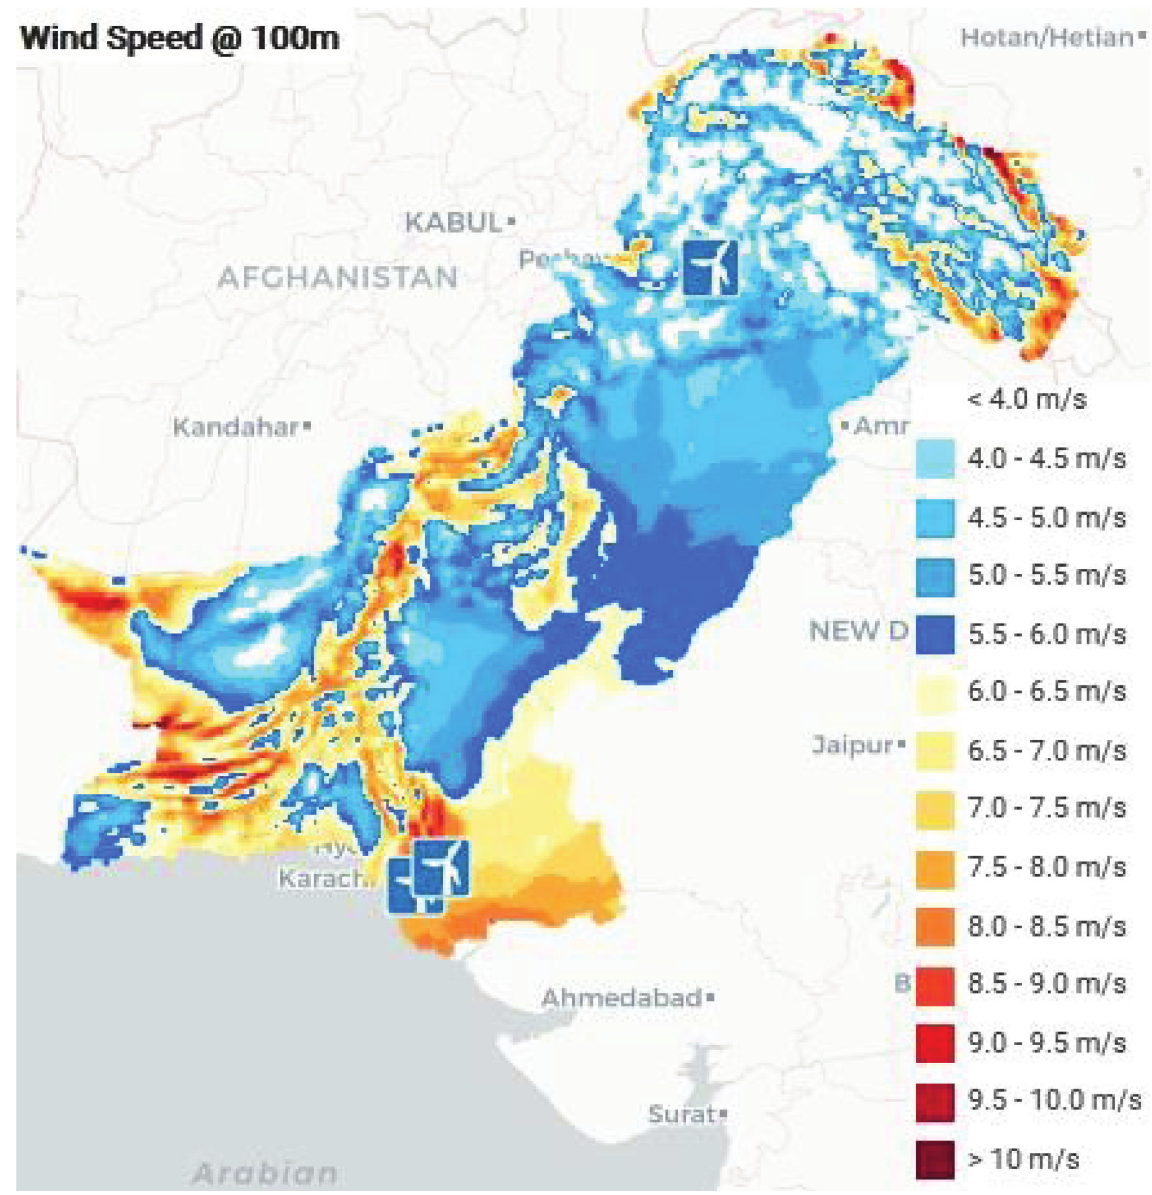
Figure 6: Location of large wind power plants in Pakistan